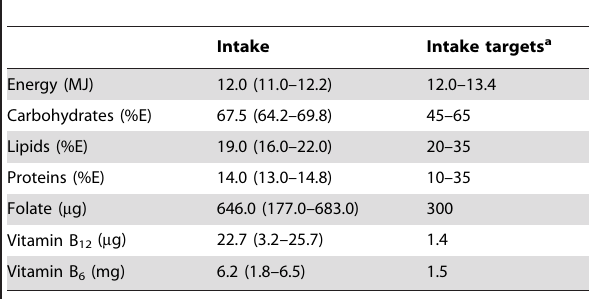
Table 3. Nutritional intake of volunteers (n=8) during the experimental trial days, target energy intake, Recommended Dietary Allowances (RDA) and Acceptable Macronutrient Distribution Range